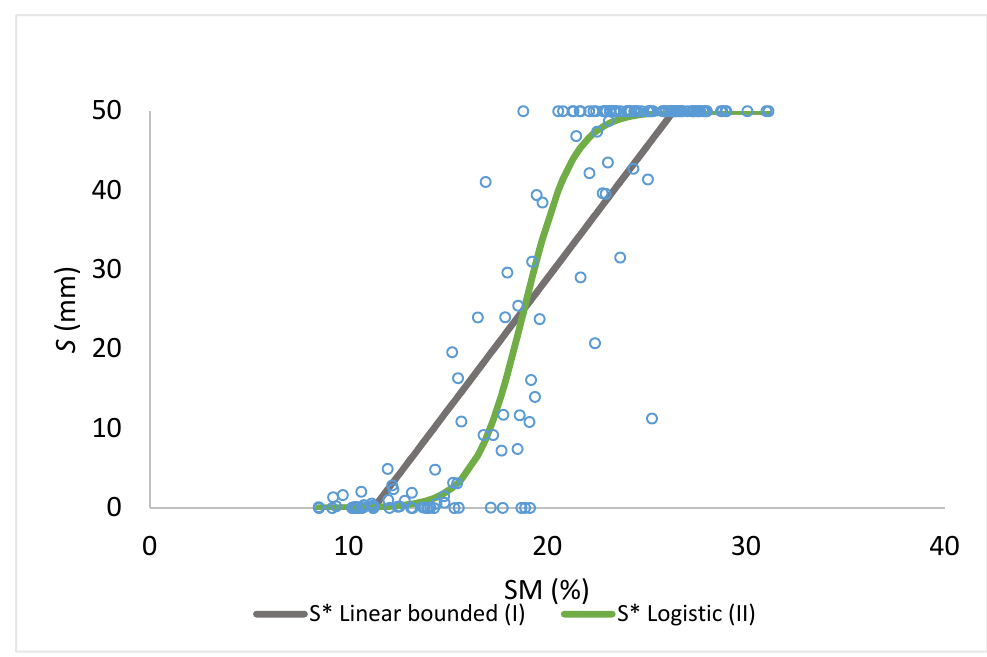
Figure 6. Regression models fitted to the data series: example for Smax 50 mm ( S * stands for S estimates by the regression model). The determination coefficients ( r 2 ) ranged from 0.690 (model II, logistic, with Smax 150 mm) to 0.886 (model II, logistic, with Smax 50 mm), meaning a minimum